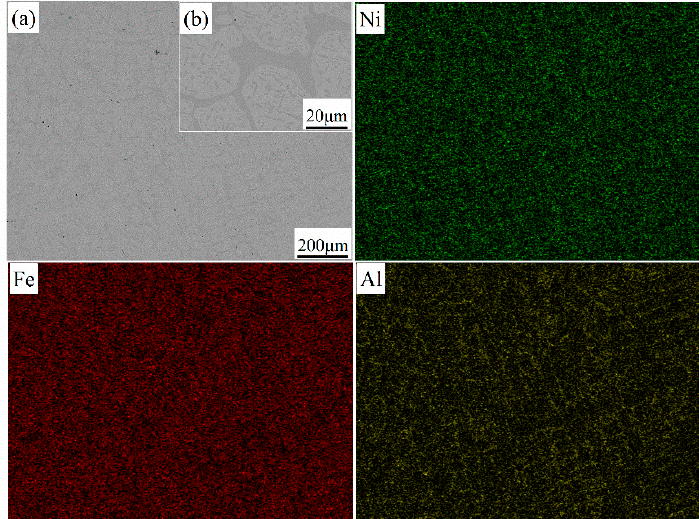
Figure 1. The scanning electron microscopy (SEM) micrograph ( a ) and energy dispersive spectroscopy (EDS) mapping of 54.1Fe-37.3Ni-8.6Al alloy sample; ( b ) microscopic morphology of the alloy at higher magnification. Table 1. The purity of aluminum obtained by inert anode electrolysis at 850 ◦ C. Elemental Mass Fraction / Anode Samples